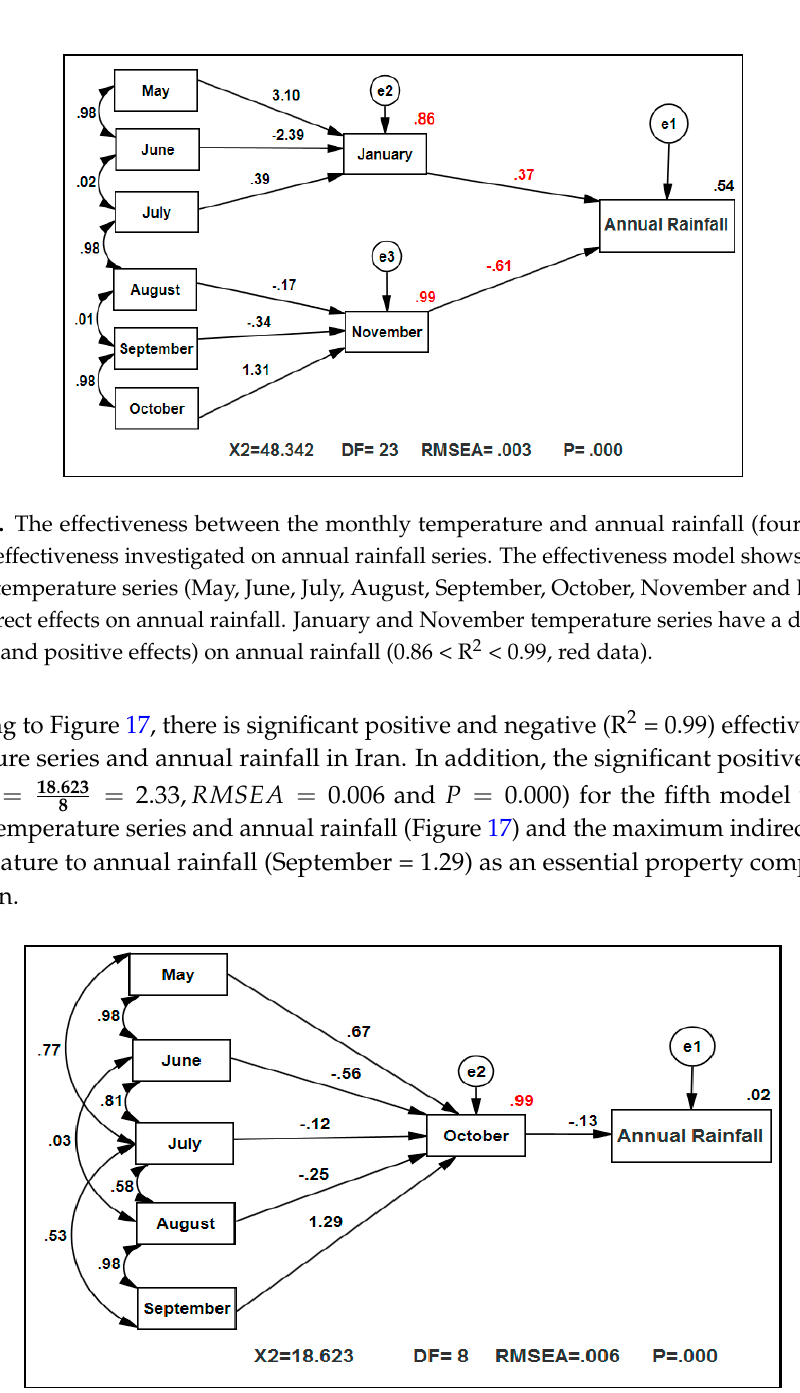
Figure 17. The effectiveness between the monthly temperature and annual rainfall (fifth model). Monthly effectiveness investigated on annual rainfall series. The effectiveness model shows that six monthly temperature series (May, June, July, August and September) have an indirect effect on annual rainfall. October temperature has a direct effect (negative effect) on annual rainfall ( R (cid:2870) = 0.99 or 99%, red data).